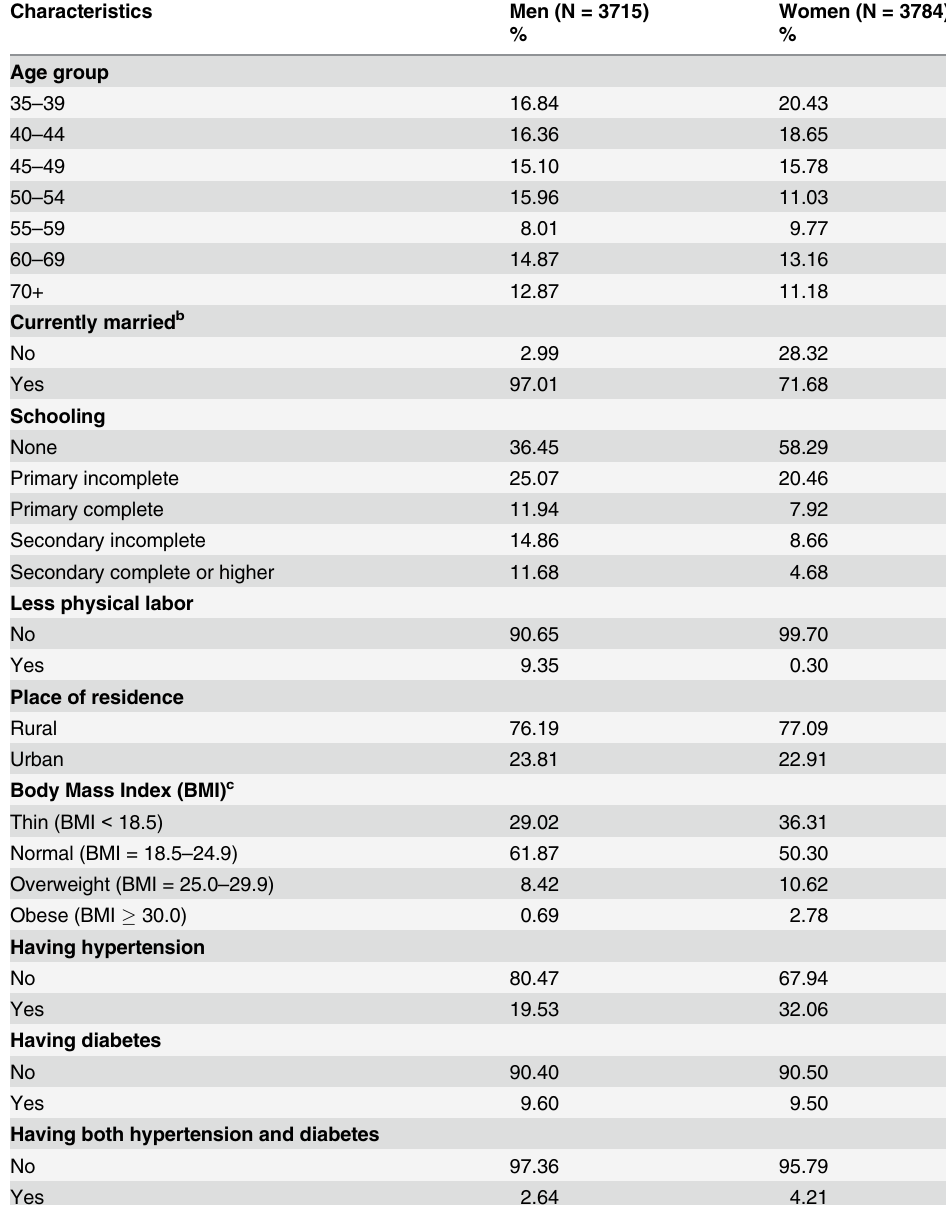
Table 1. Sample characteristics a